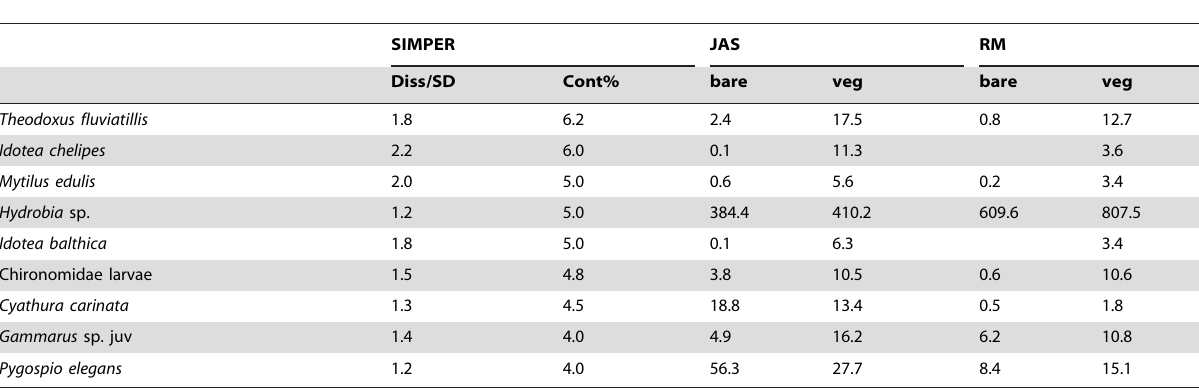
Table 5. Species responsible for discrimination of macrofauna between two bottom types, as indicated by the SIMPER procedure based on double-root transformed